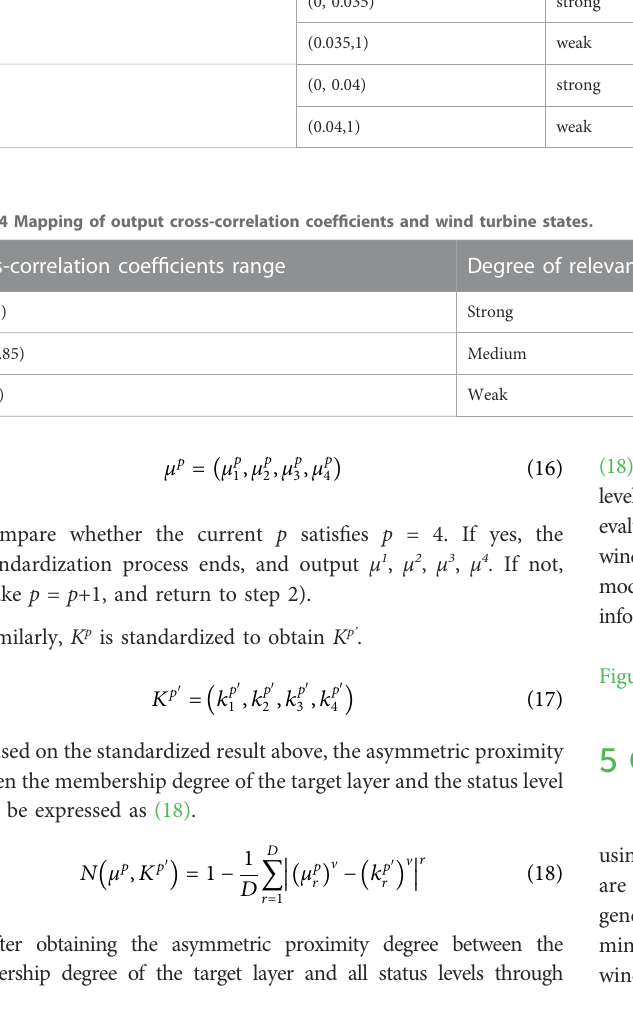
TABLE 3 Mapping between the difference of self-correlation coef fi cient and the state of the whole machine. Delay time (min)